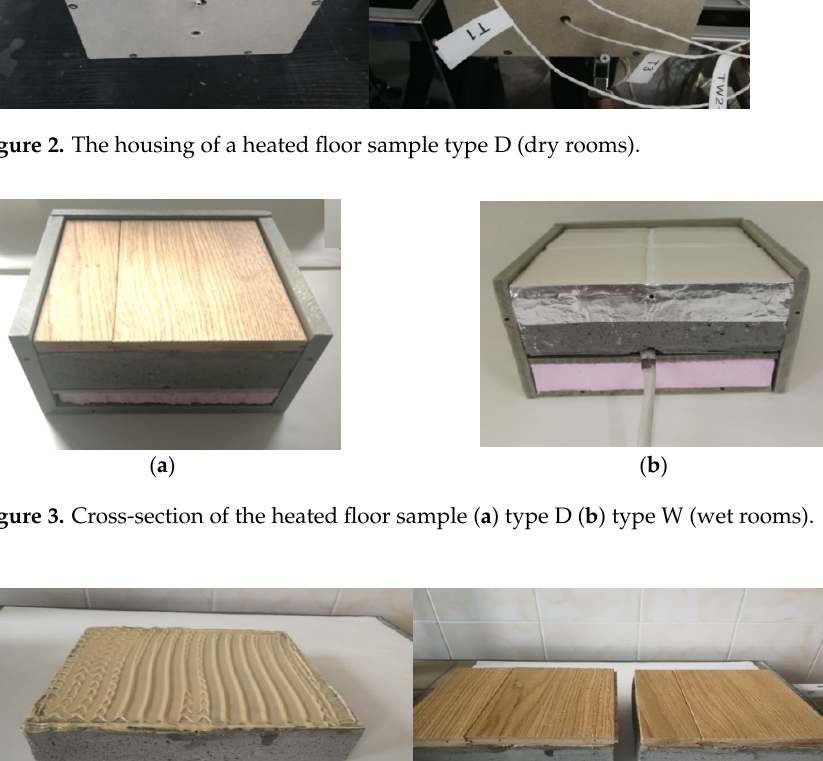
Figure 4. Picture of a cross-section of the sample type D (dry indoor conditions).